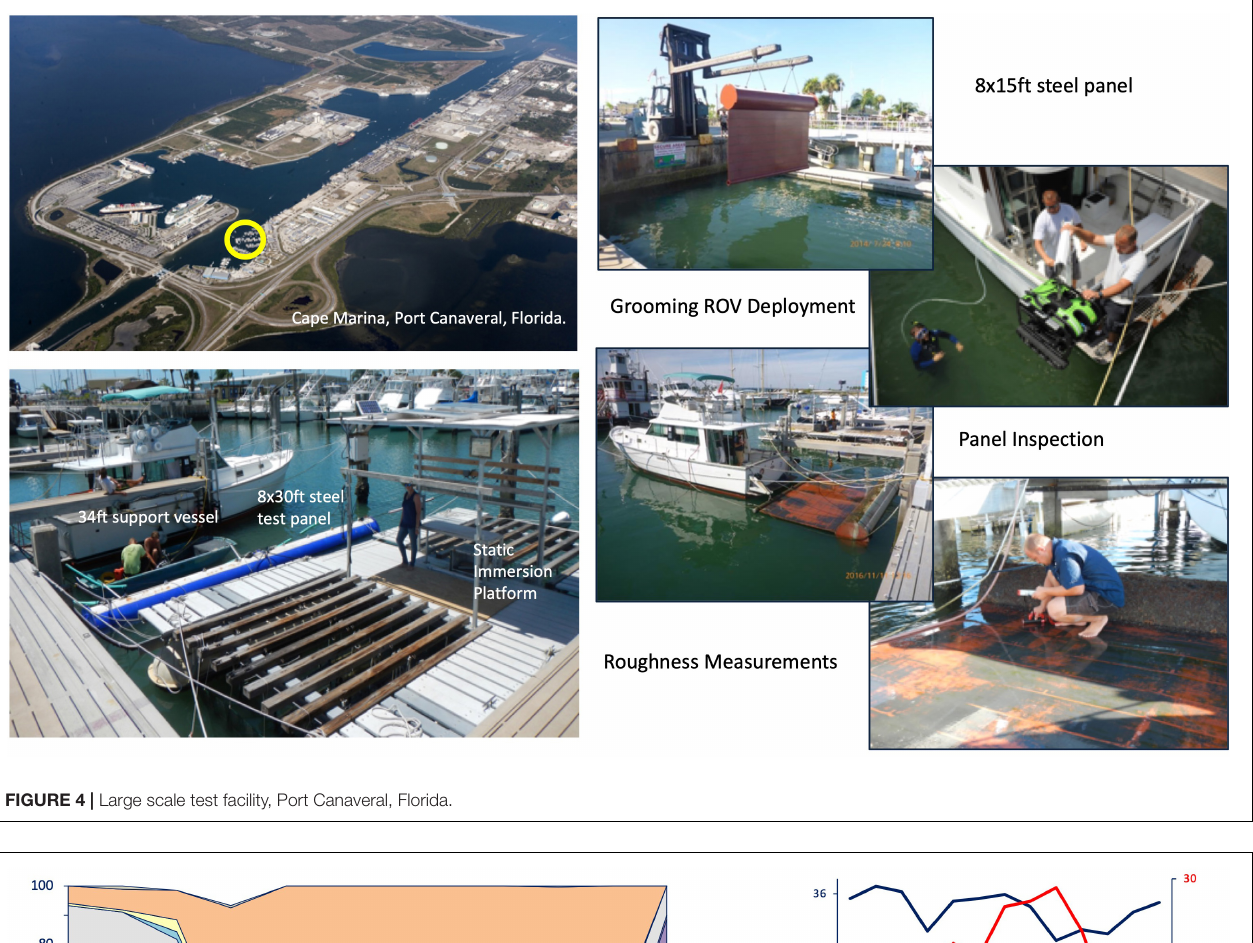
FIGURE 4 | Large scale test facility, Port Canaveral, Florida.